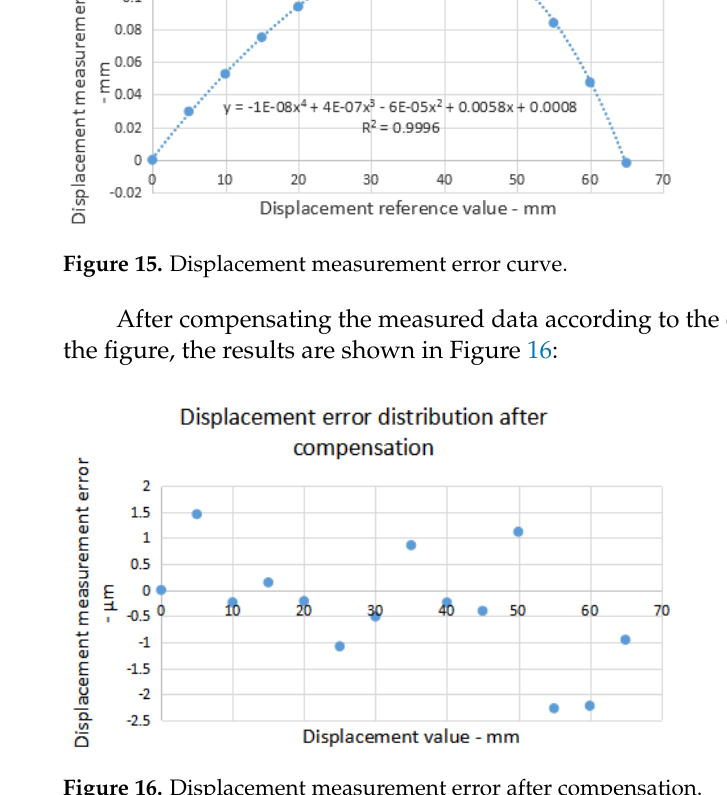
Figure 16. Displacement measurement error after compensation.